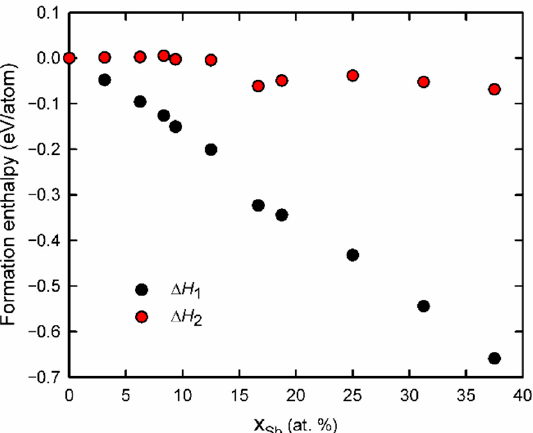
Figure 5. DFT-calculated formation enthalpies of Sb-doped SnSe phases plotted as a function of Sb atomic concentration, considering only potential energies. Black dots: formation enthalpy Δ H 1 as defined to SnSe, Sb 2 Se 3, and elemental Sn using Equation (3). Red dots: formation enthalpy Δ H 2 including a correction with a chemical potential shift of Sn as defined by Equation (4). The compositions and enthalpies are also listed in Supplementary Table S8.